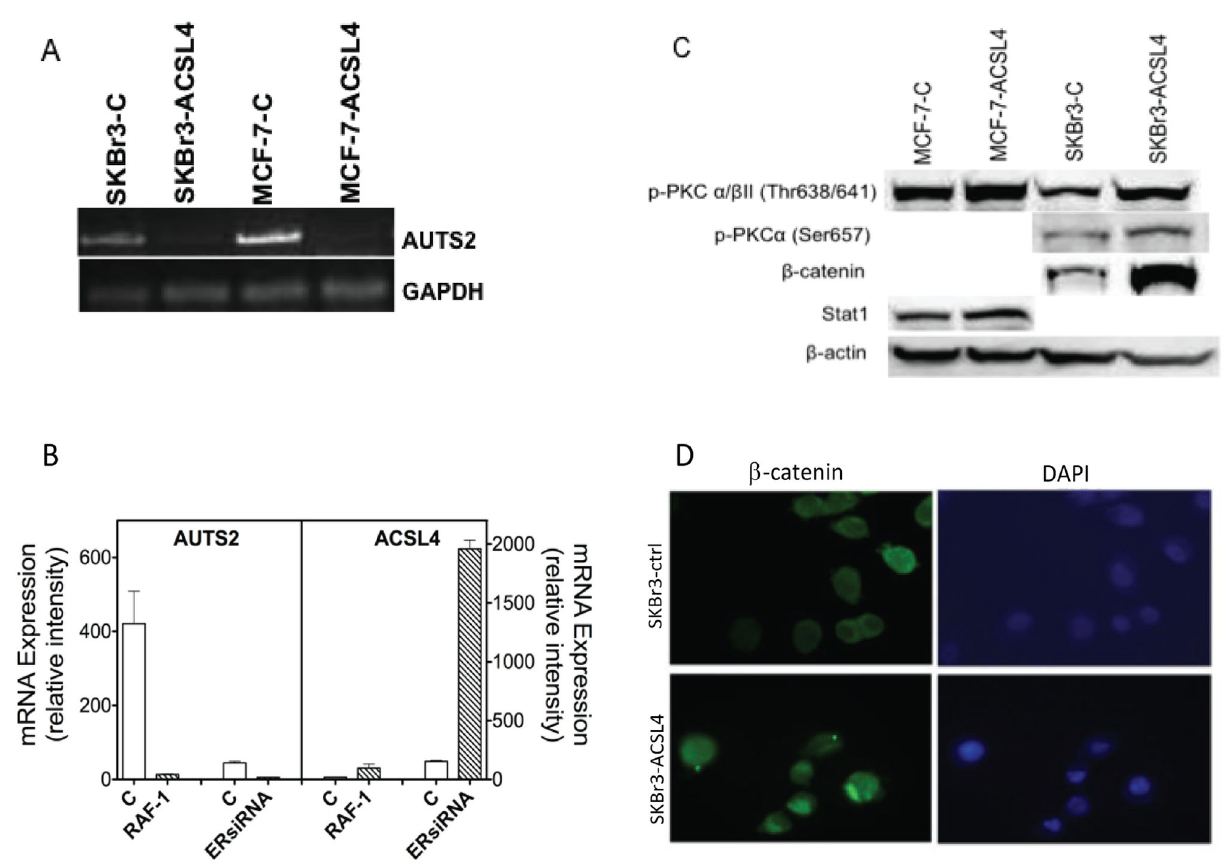
Figure 9. Validation of microarray and proteomic pathway analysis data. Panel A illustrates results from a semi-quantitative RT-PCR analysis of control- and ACSL4-transfected MCF-7 and SKBr3 cells. Both transfections were carried out with lentivirus vectors as described in the text. Panel B documents changes in AUTS2 expression as a result of transfection of MCF-7 cells with either RAF-1 or siRNA directed against ER. Values shown represent the means of three determinations ± 1SD. The differences between controls and transfected cells are significant, p=1.0E-03 and p=9.0E-06, respectively. Data were taken from microarray studies GDS1925 and GDS4061 deposited at http://www.ncbi.nlm.nih.gov/geo/ . Panel C depicts an immunoblot analysis of selected pathway proteins. Fold changes observed for expression of p-PKCα/βII (Thr638/641) are 1.4 in MCF-7 cells and 1.9 in SKBr3 cells; for expression of p-PKCα is 2.0 in SKBr3 cells; for expression of β-catenin is 35 in SKBr3 cells; and for expression of stat1 is 1.1 in MCF-7 cells. Panel D shows immunofluorescent staining of β-catenin in control and ACSL4-transfected SKBr3 cells. Methods were as described in the